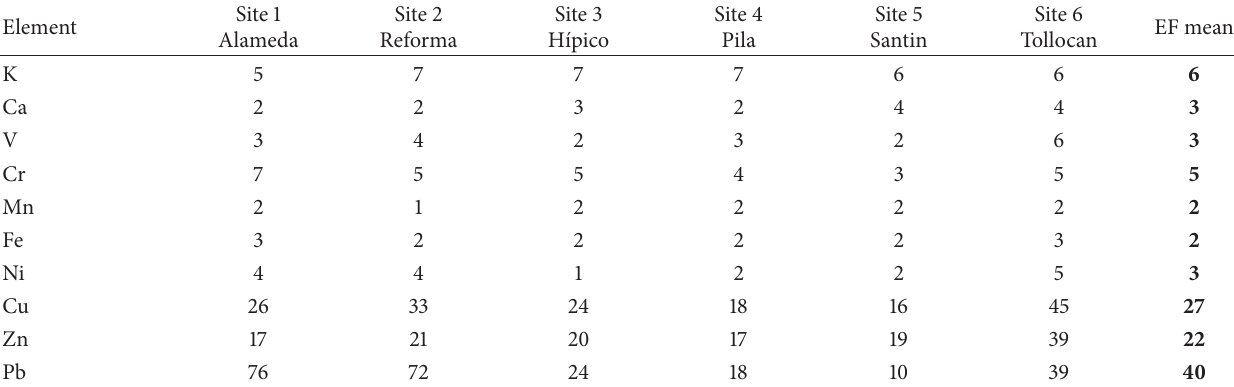
Table 6: Moss enrichment factors (EFs) from samples sites at the Metropolitan Zone of the Toluca Valley. Site Element